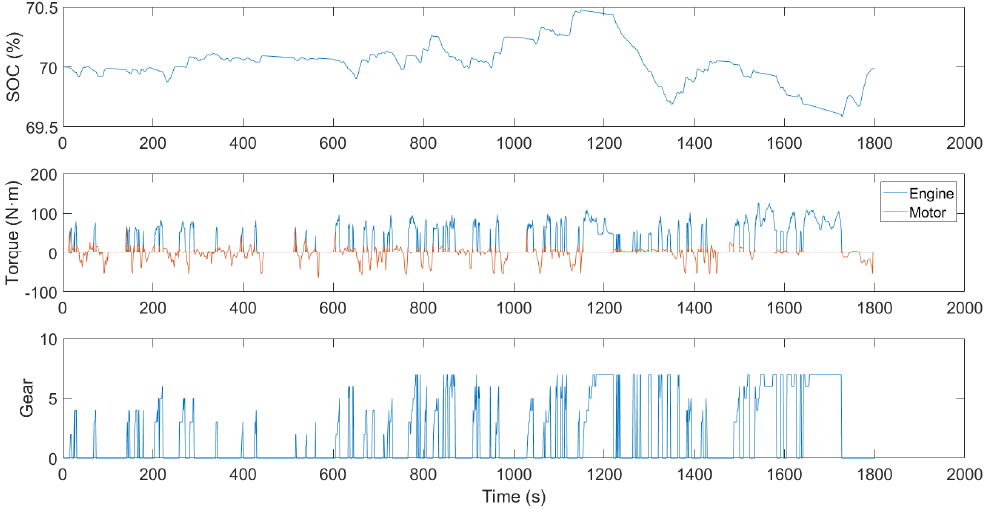
Figure A2. Three state parameters’ variation curves of µ min for emission